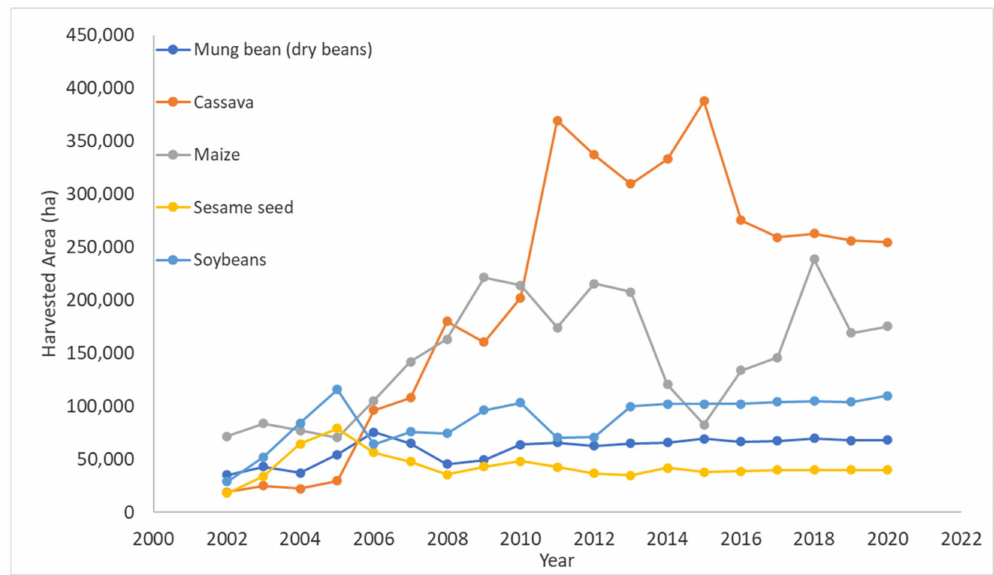
Figure 1. Harvested areas of non-rice crops in Cambodia from 2002 to 2020 (FAOSTAT, 2022